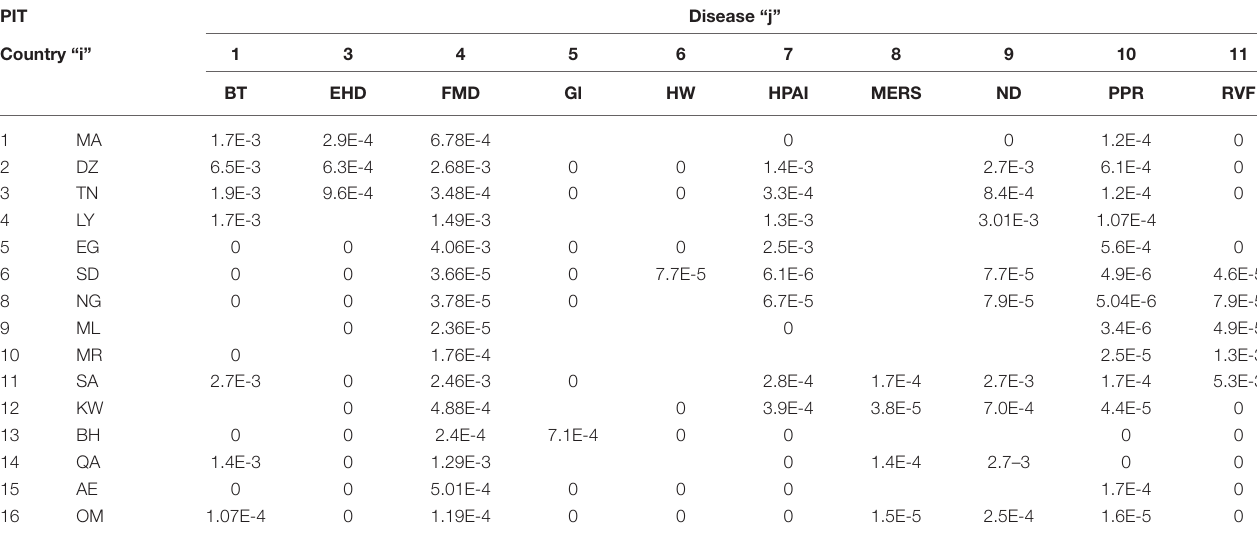
TABLE 5 | Probability of introduction of the j disease into the European Union through transport-vehicle from the country i . PIT Disease “j” Country